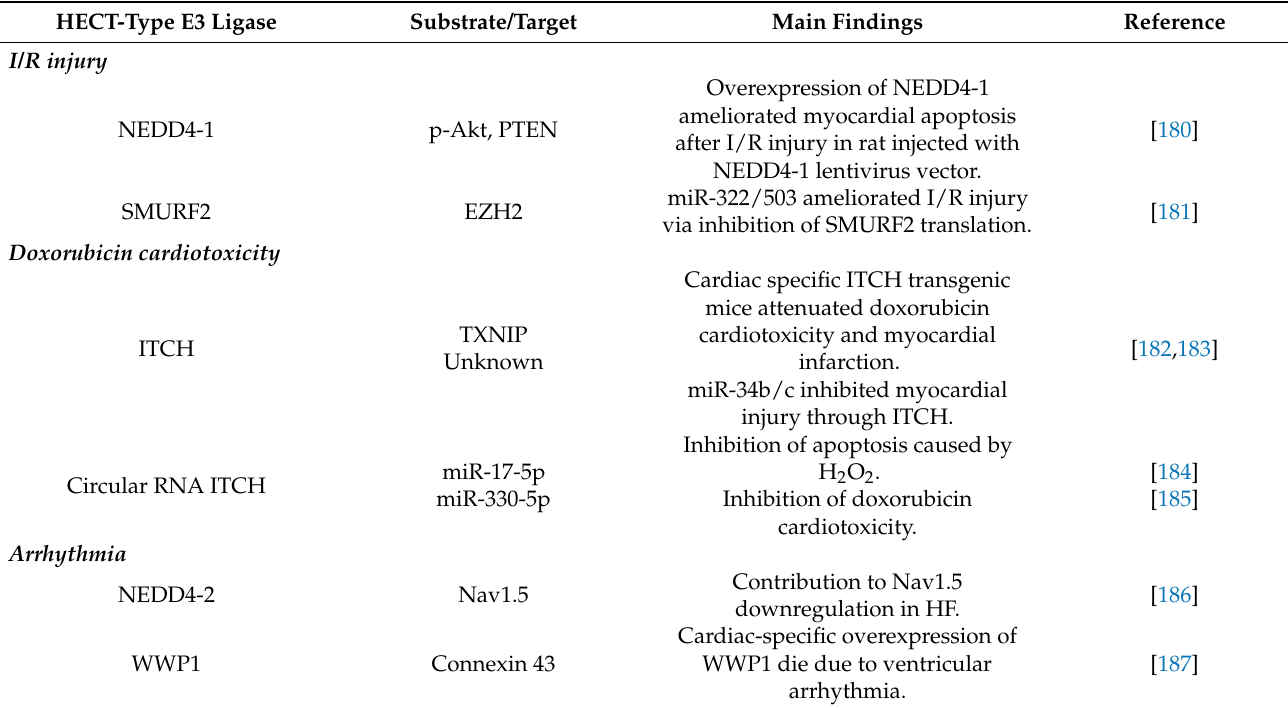
Table 2. HECT-type E3 ligase and ischemia reperfusion injury, doxorubicin cardiotoxicity, and arrhythmia. HECT-Type E3 Ligase Substrate/Target Main